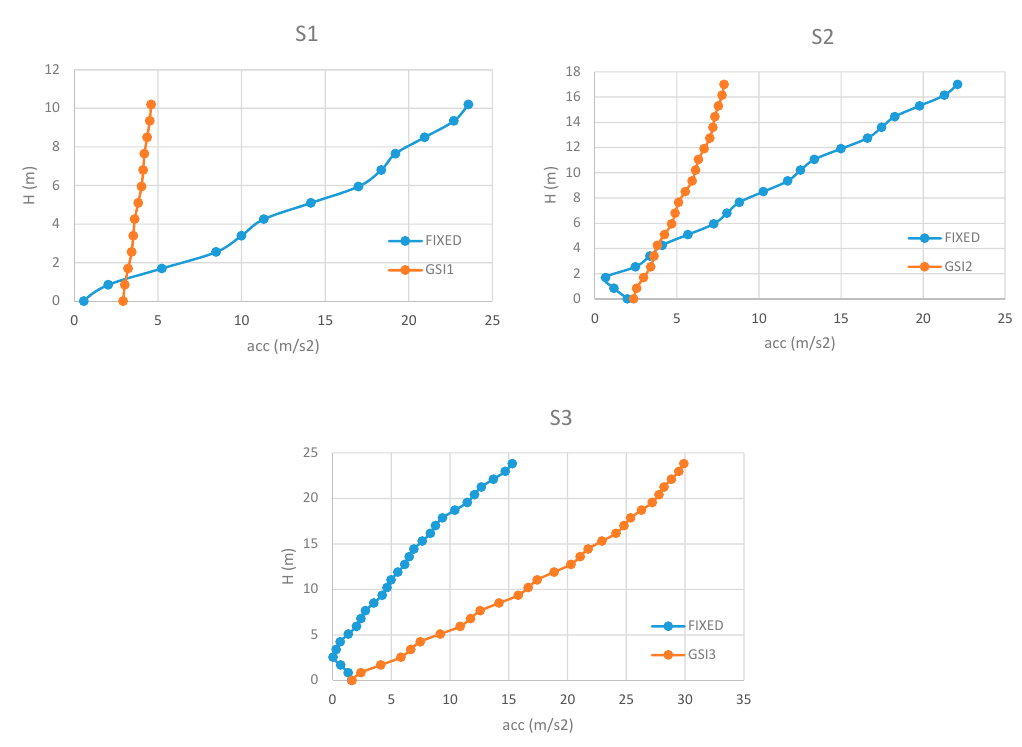
Figure 10. Maximum accelerations along the height (IM2).